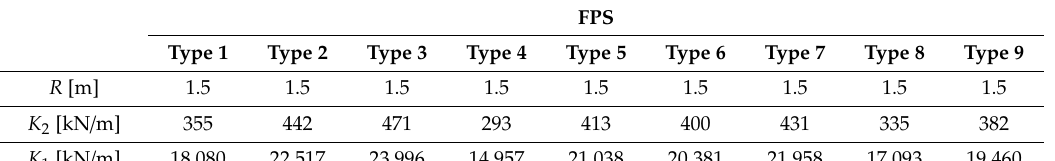
Table 2. Types of FP devices and related characteristics.